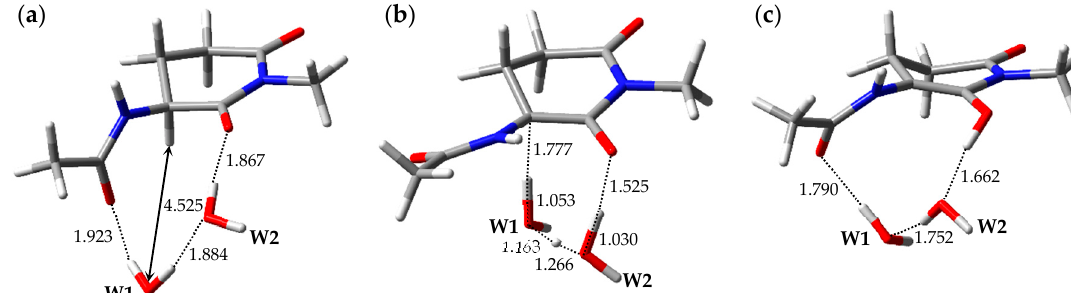
Figure 5. Optimized geometries of the enolization system in Pathway 4: ( a ) 4-RC ( ϕ = − 106 ◦ , ψ = − 157 ◦ , χ = 179 ◦ , χ = − 52 ◦ ); ( b ) 4-TS ( ϕ = − 159 ◦ , ψ = − 160 ◦ , χ 1 2 ψ = − 170 ◦ , χ = − 159 ◦ , χ = − 47 ◦ ). The selected interatomic distances are shown in 1 2